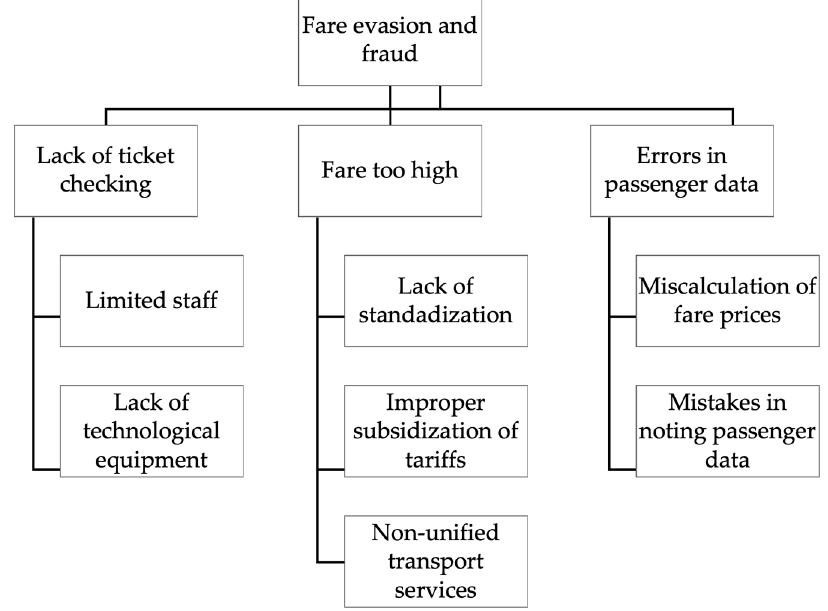
Figure 1. Fraud vulnerability root and cause analysis.